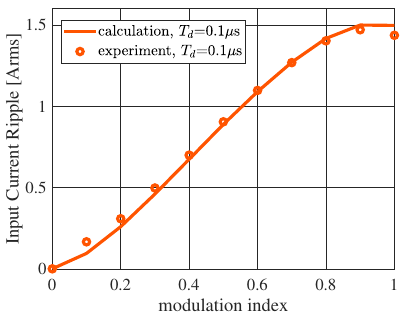
Figure 14. Calculation and experimental results of modulation index vs. rms input current ripple of the three-phase VSI (case 1 load, T d = 0.1 µ s).